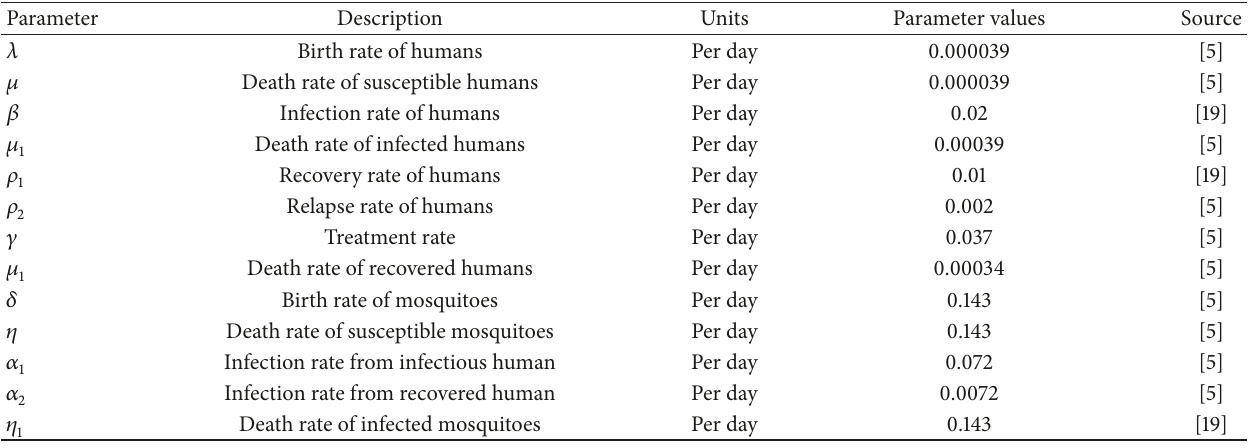
Table 2: Model parameter values.